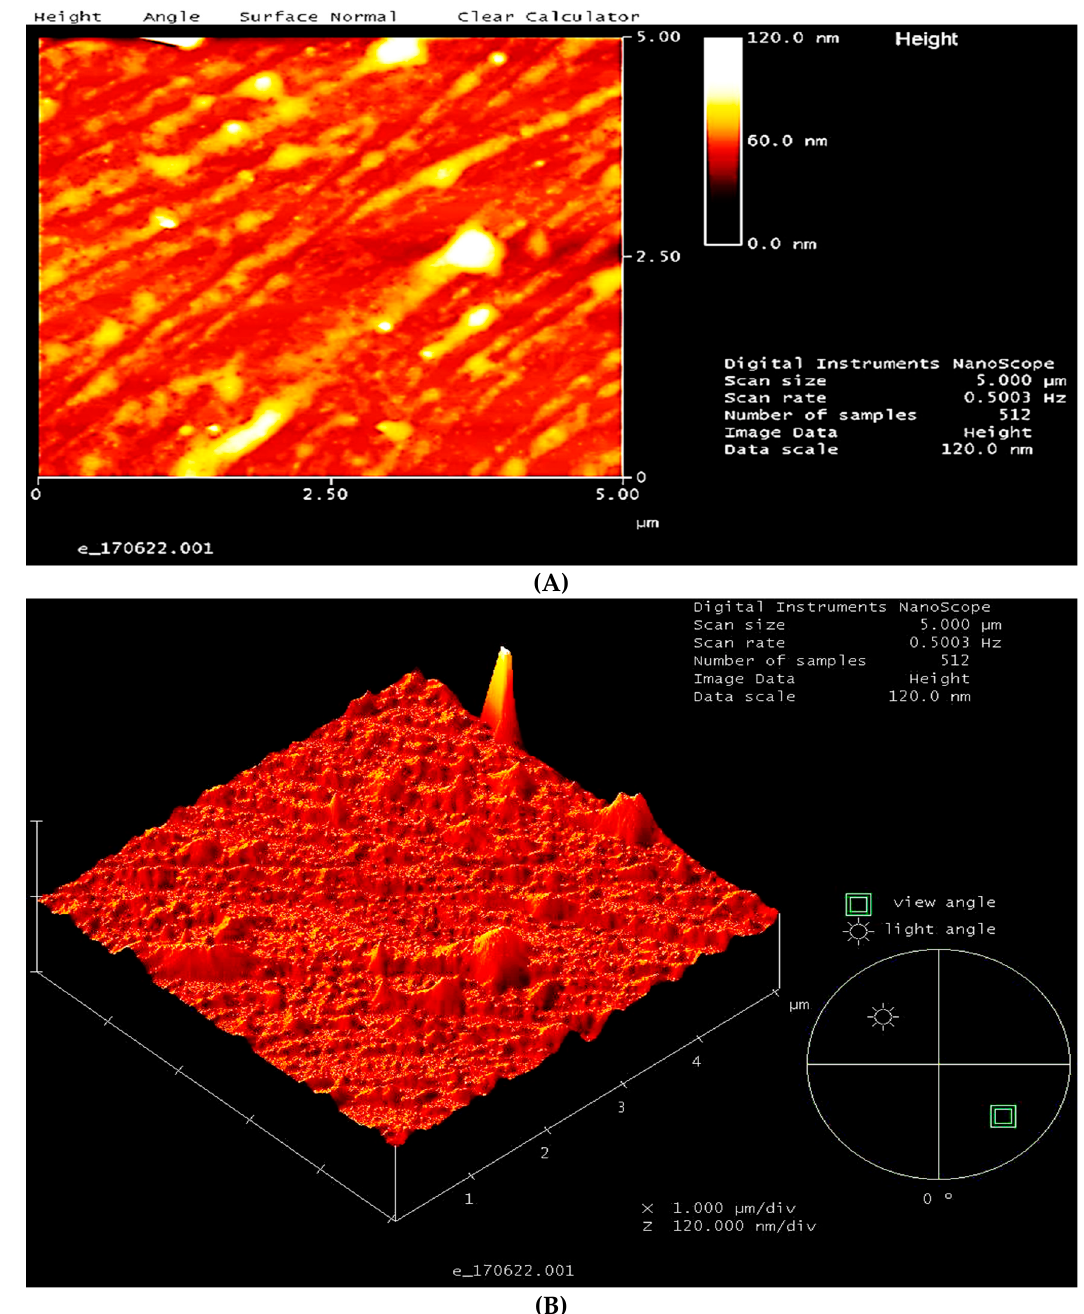
Figure 3. AFM images of AgNPs. ( A ) 2D image; ( B ) 3D image. The EDX analysis by FESEM generated a spectrum, as seen in Figure 4. The spectrum revealed the elemental composition of AgNPs. EDX spectra determined silver (64.05%) as a major constituent element in comparison to chlorine (20.75%) and calcium (15.20%).